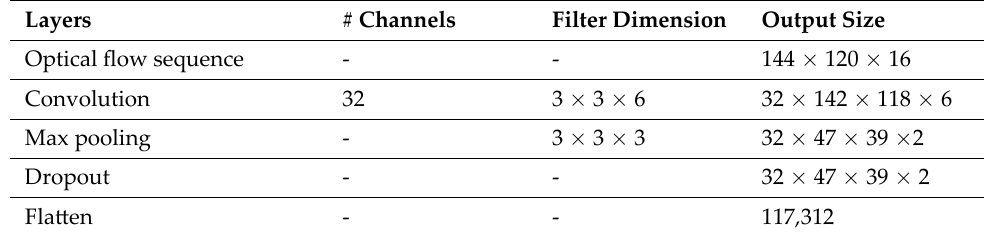
Table 2. Network components of the optical flow